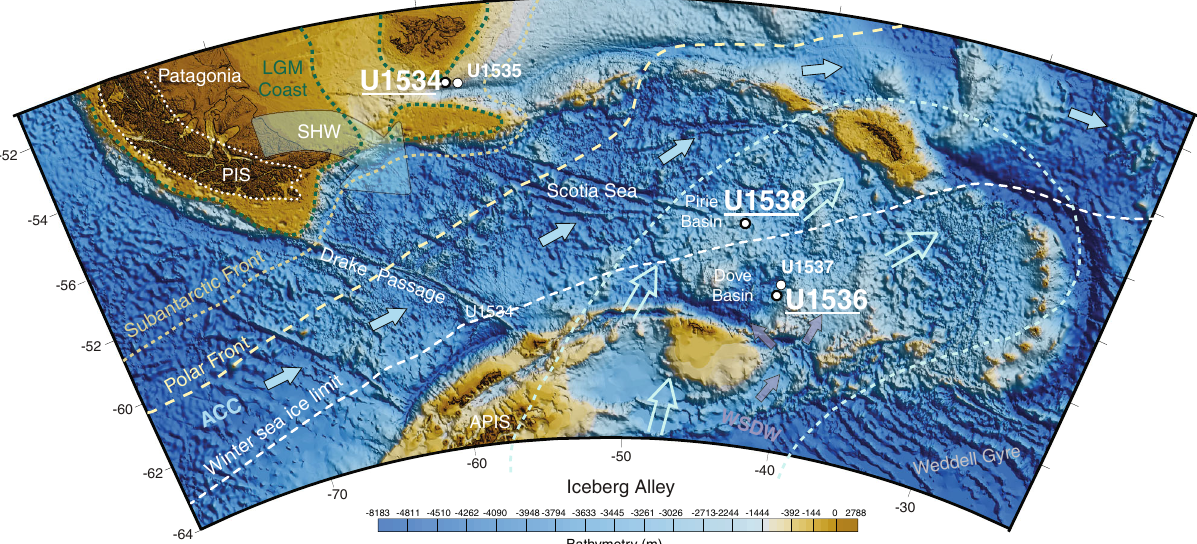
Fig.1|IODPExp.382SiteMap. Coringsitesatwhich sed aDNAsamplingwasperformedincludeU1534(FalklandPlateau),U1536(DoveBasin)andU1538(PirieBasin).Map adapted from IODP 23 and created using ref.